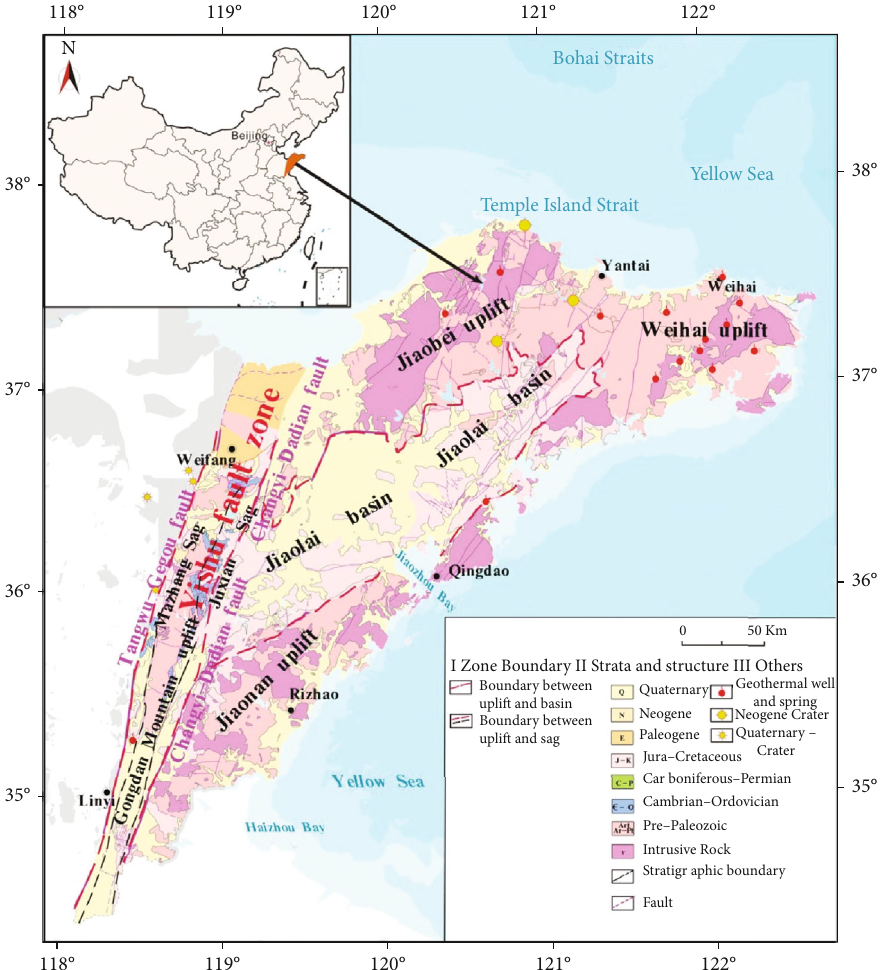
Figure 3: Location of the study area and distribution of geothermal geology